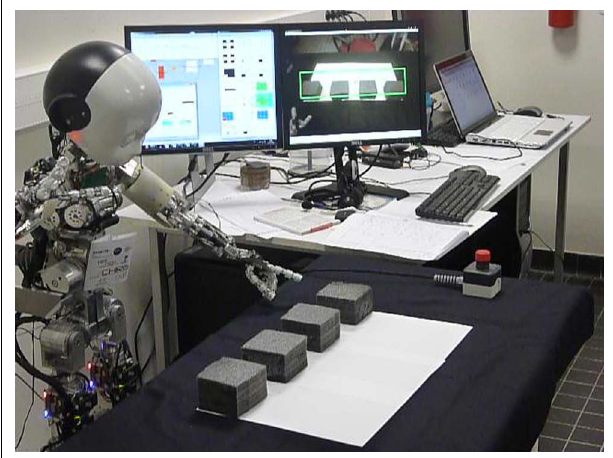
FIGURE 3 | iCub robot performing Experiment 3. The robot chooses among four cubes on a table.The left screen tracks simulated activity in the neural-network model.The right screen shows the perception of the robot.